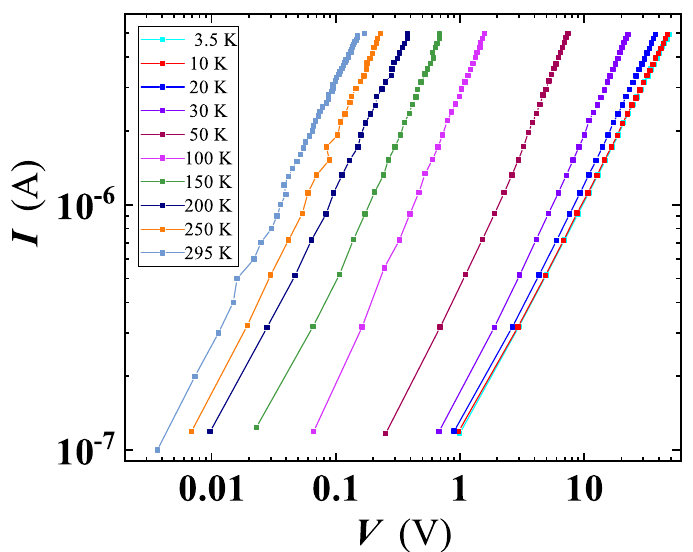
Figure 8. Current-voltage characteristics at several fixed temperatures, for a voltage-biased GS sample. Lines are shown as guides for the eyes.